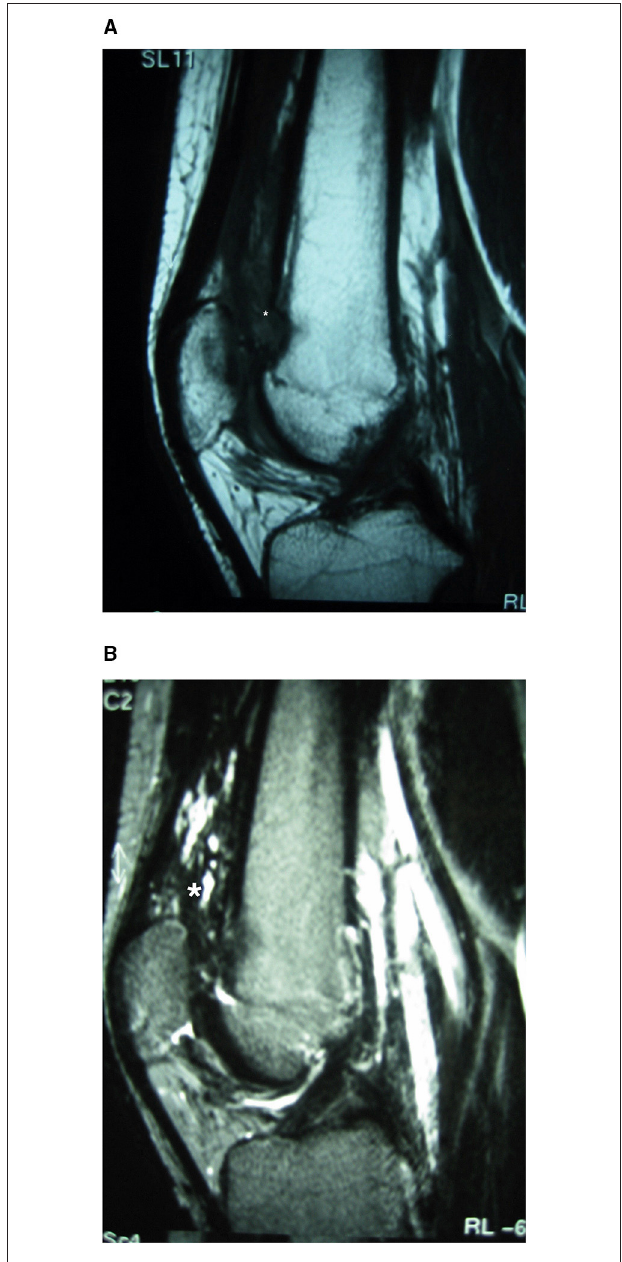
FIGURE 3 | Case 1: suprapatellar MRI tumor recurrence. MRI showing recurrence of the lesion. A heterogeneous hyperintense lesion is observed on sagittal T2-weighted imaging (B) ; it contains fibrous septa and is hypo-/isointense to muscles on the T1 sequence (A) , with diffuse involvement of the sub-quadriceps synovial sac and tendon. *Location of the Synovial Haemangioma tumor in the knee.